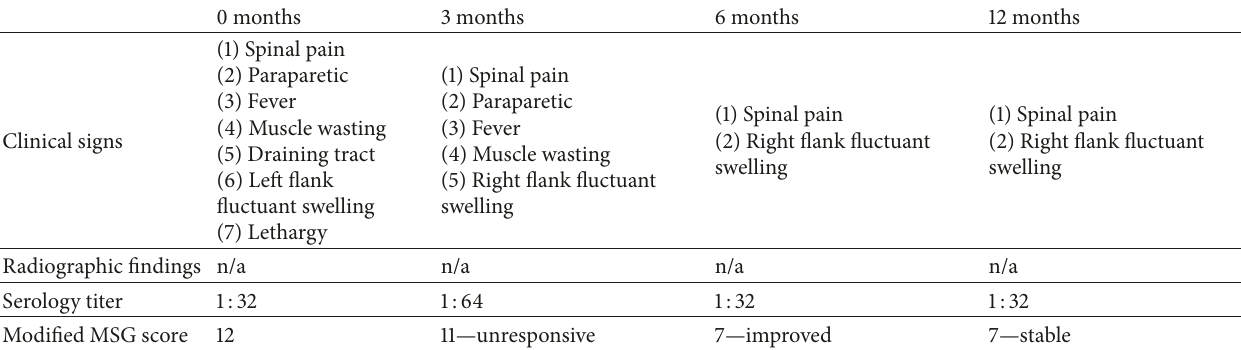
Table 1: Modified MSG score . The MSG score is a composite score, comprising the sum of points assigned by the following characteristics: (1) a clinical signs score, with 1 point given for each sign listed; (2) a radiographic imaging scoring system, with points assigned for the size of the abnormality, the presence of satellite lesions, associated adenopathy, and changes in size or presence of infiltrates; and (3) serology points, with a complement fixation titer of 1: 2 assigned 1 point, 1: 4 assigned 2 points, 1:8 assigned 3 points, and so forth. The patient’s response to treatment was classified as either improved, stable, or unresponsive. An improved outcome was defined as one of the following: (1) a score ≤ 50% of the pretreatment composite score; (2) the unequivocal documentation of clinical improvement; or (3) a 25–49% decrease in the MSG score and the clinician’s impression of improvement. A stable outcome was defined as an unchanged MSG score or one that declined by < 25% by the end of follow-up. An unresponsive outcome was defined as one of the following: (1) the MSG score increased (reflecting